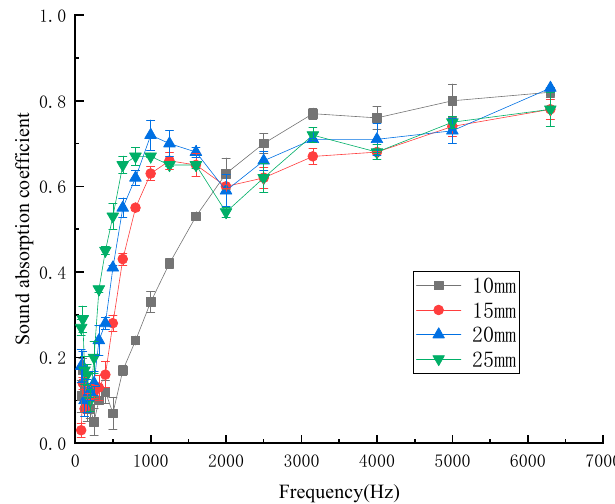
Figure 8. Sound-absorption coefficient with different thicknesses.